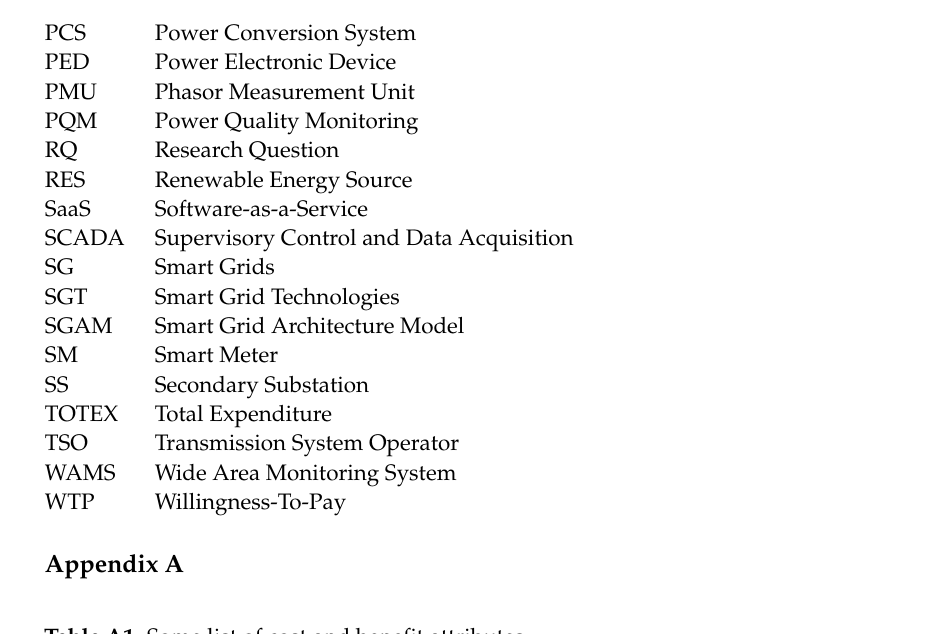
Table A1. Some list of cost and benefit